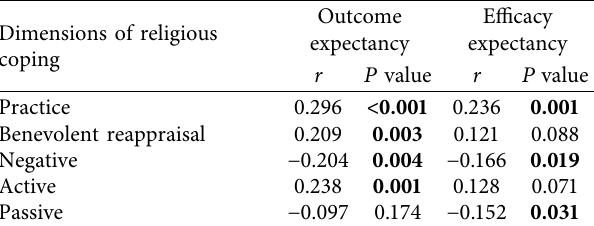
Table 3: The relationships between religious coping and childbirth self-efficacy of the primiparous women ( n � 200). Dimensions of